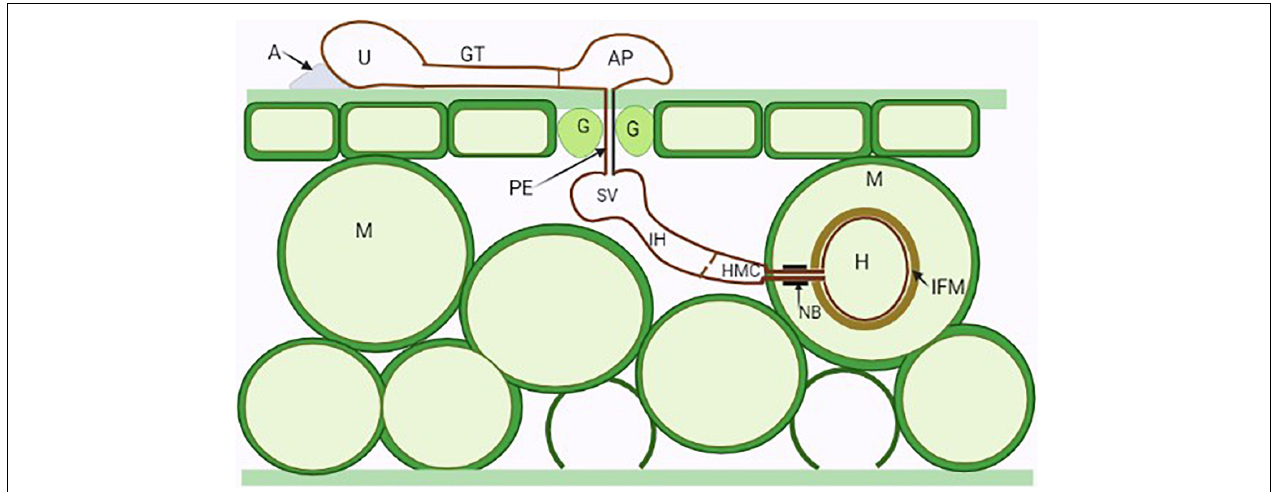
FIGURE 1 | Illustration of the general infection process of a dikaryotic stage rust fungus. A urediospore (U) attached to an adhesion pad (A) germinate forming germ tubes (GT) which sense the topography of host cuticle and develop appressoria (AP) above stomata (Guard cells—G). Penetration occurs through stomata by the penetration hyphae (PE) into the substomatal spaces where the fungus differentiates into substomatal vesicles (SV) and elongates into an intercellular hypha (IH) which comes into contact with the host mesophyll cells (M) and develops haustorial mother cells (HMC). Following this, haustorial formation is initiated, neckbands (NB) are formed around the site of penetration of the mesophyll cell and an interfacial matrix (IFM) develop between the haustoria cell wall and the cell plasma membrane.